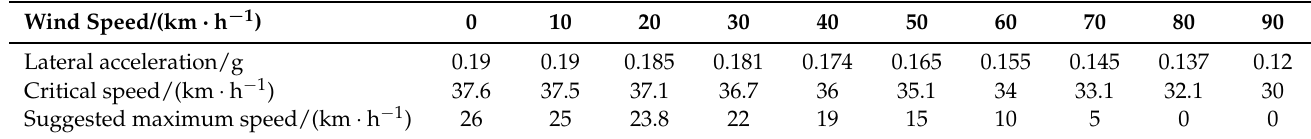
Table 5. Correlation between lateral acceleration, critical speed, and crosswind wind speed.